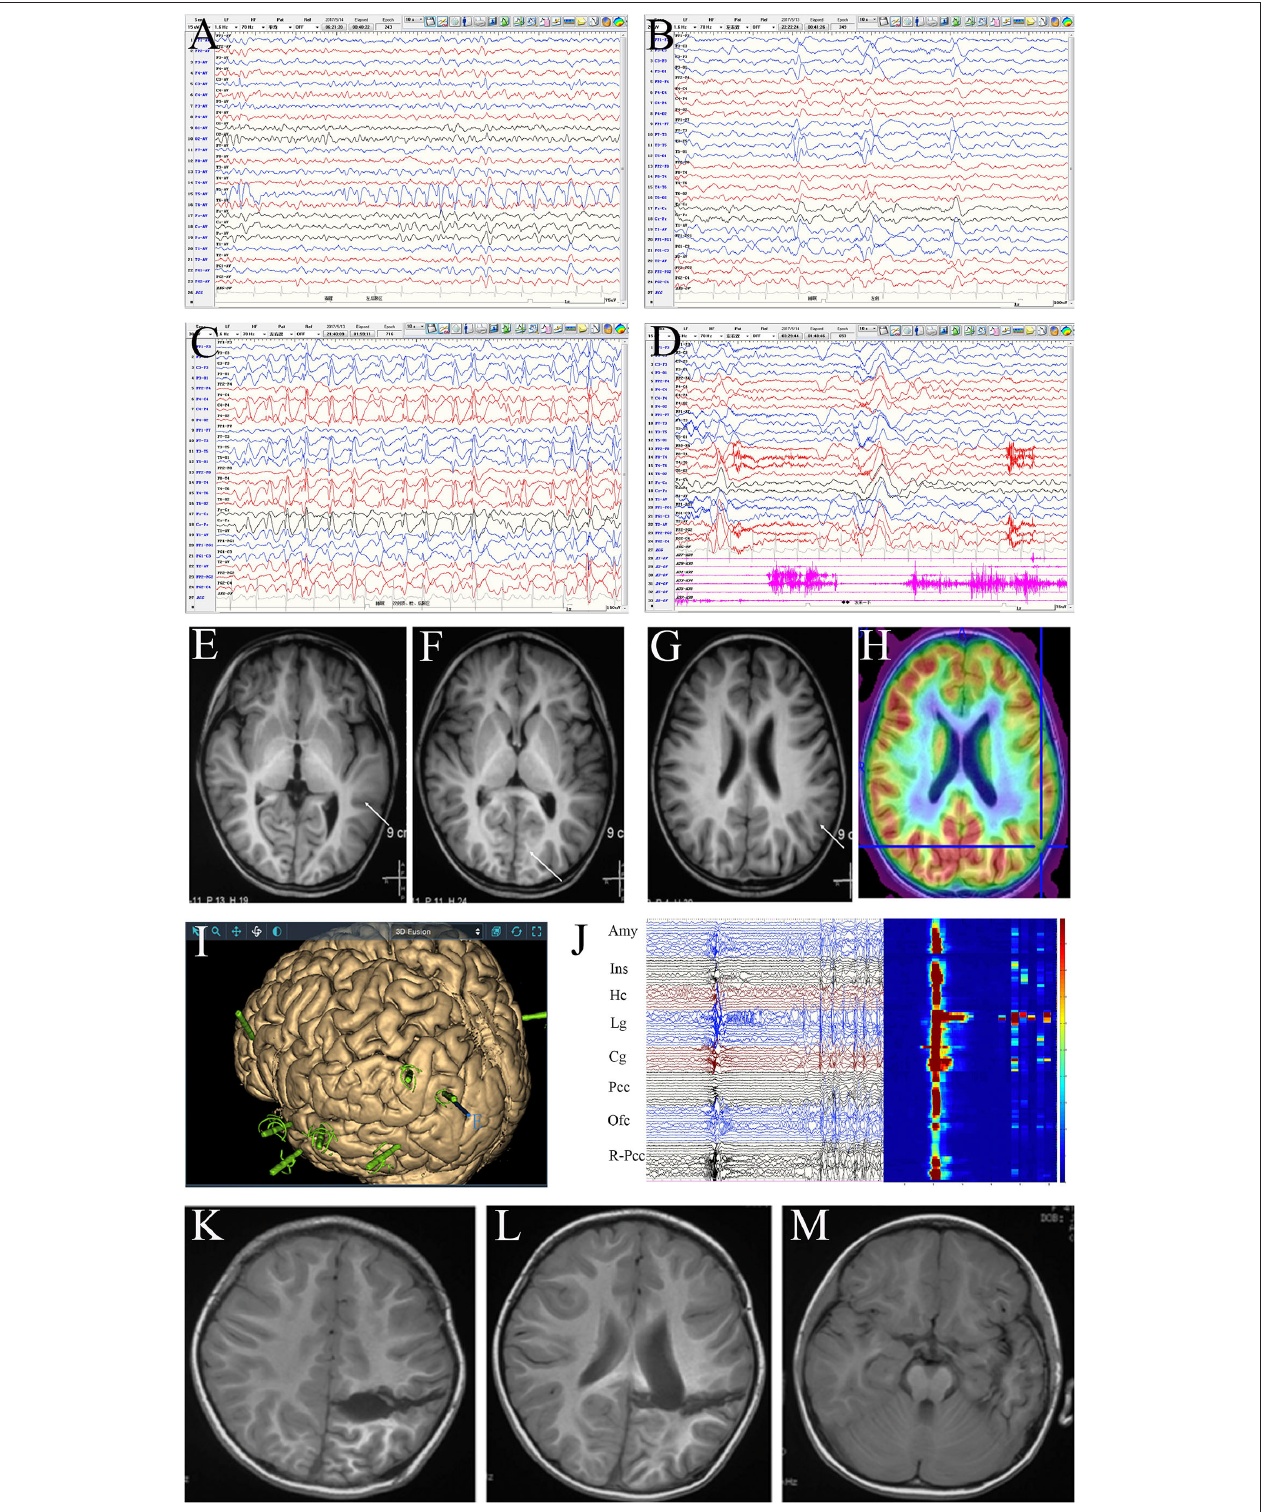
FIGURE 3 | Evaluation of a female patient, 4 years and 4 months old, with onset age at 3 years and 3 months and clustered or isolated symmetrical epileptic spasm (ES) as well as frequent daily seizures. The patient had been prescribed several anti-seizure medicines, including adrenocorticotropic hormone, vigabatrin,